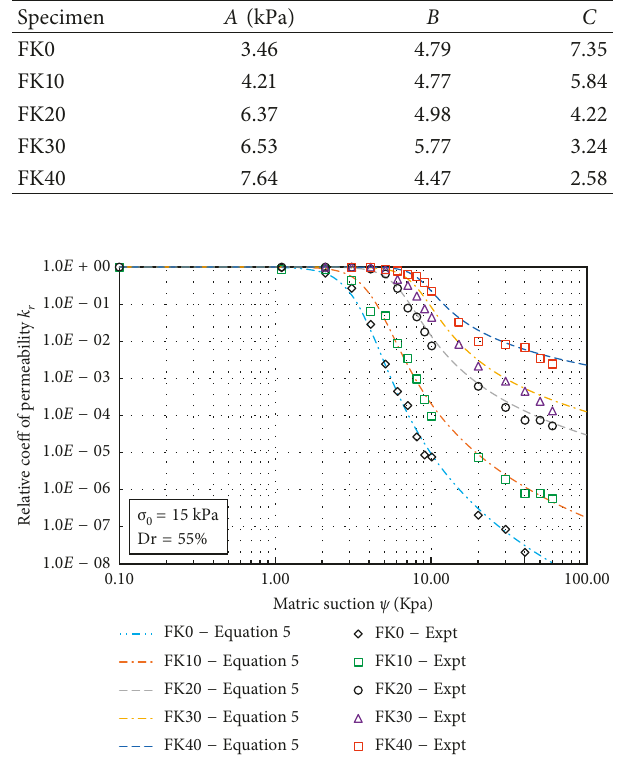
Figure 10: A comparison graph for permeability changes against matric suction for different soils.